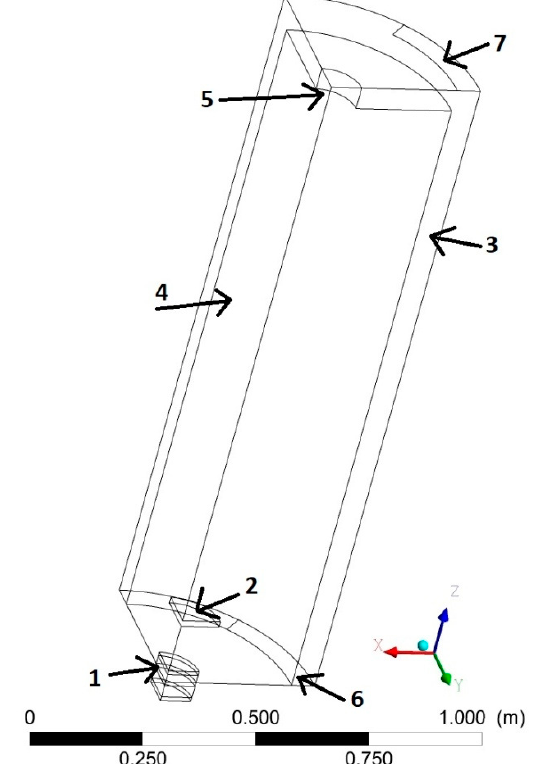
Figure 3. Overview on a computational domain, 1—volume of fixed bed, 2—deflector, 3—water jacket, 4—combustion chamber, 5—exhaust gas outlet, 6—cooling water inlet, 7—cooling water outlet. Table 2. Parameters of the grid used in numerical calculations.